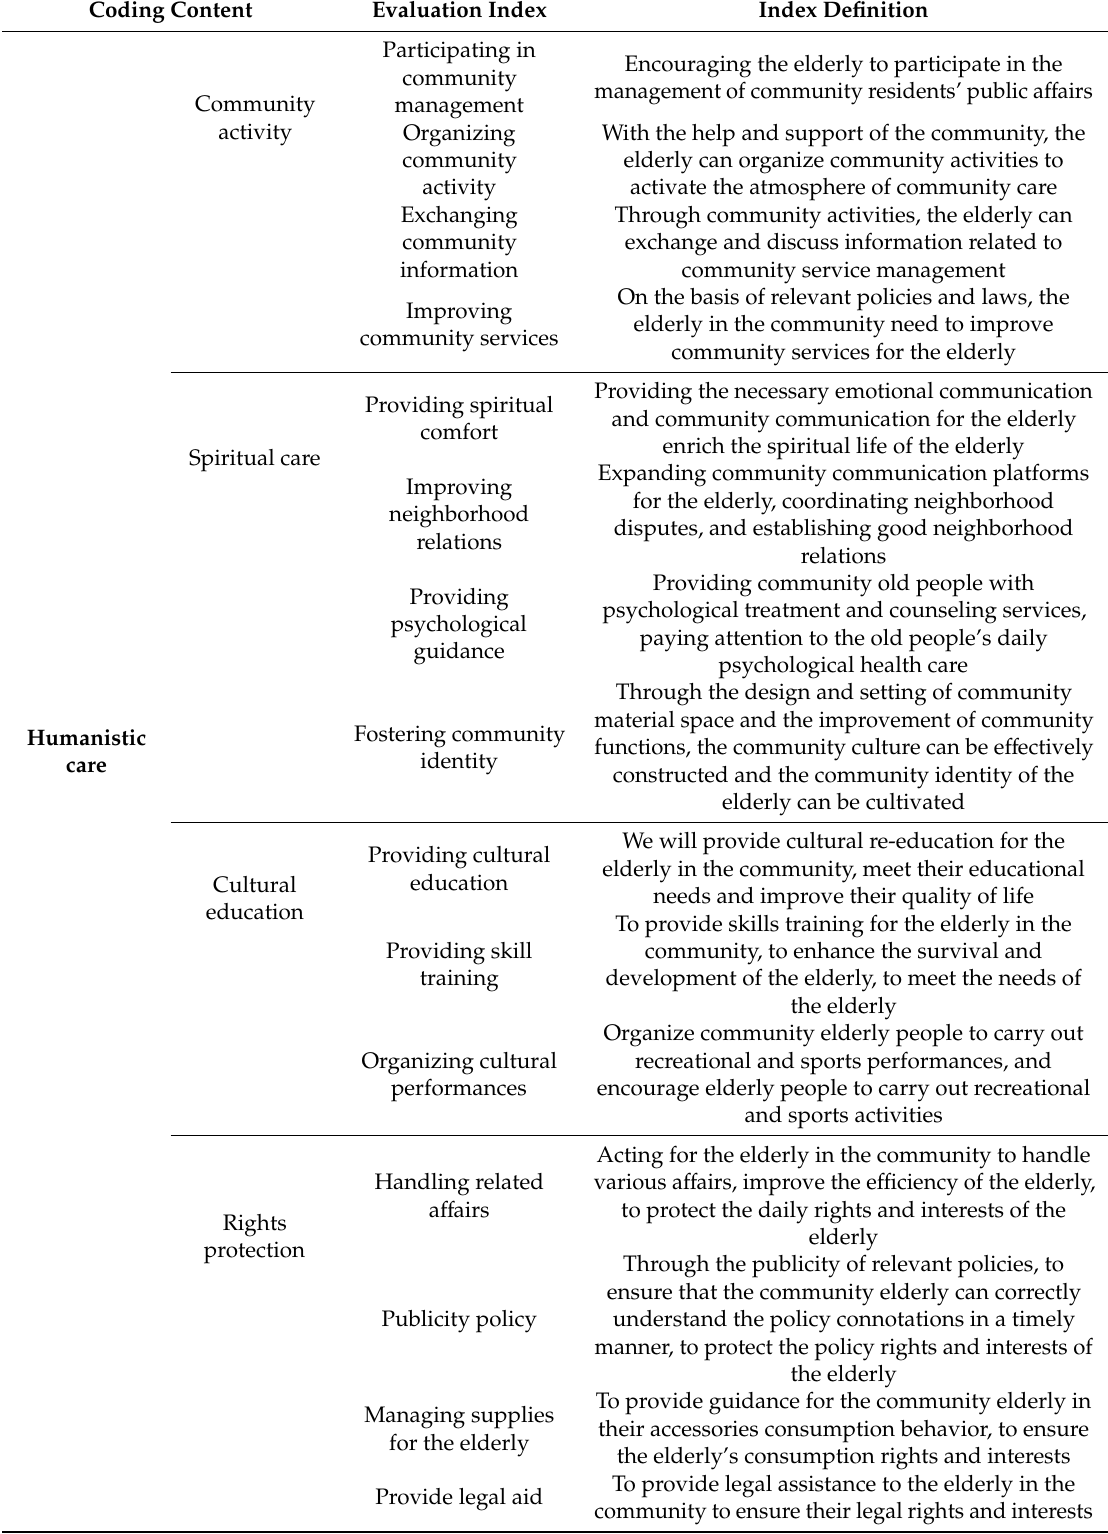
Table 4. Assessment indicators and interpretation of community building suitable for